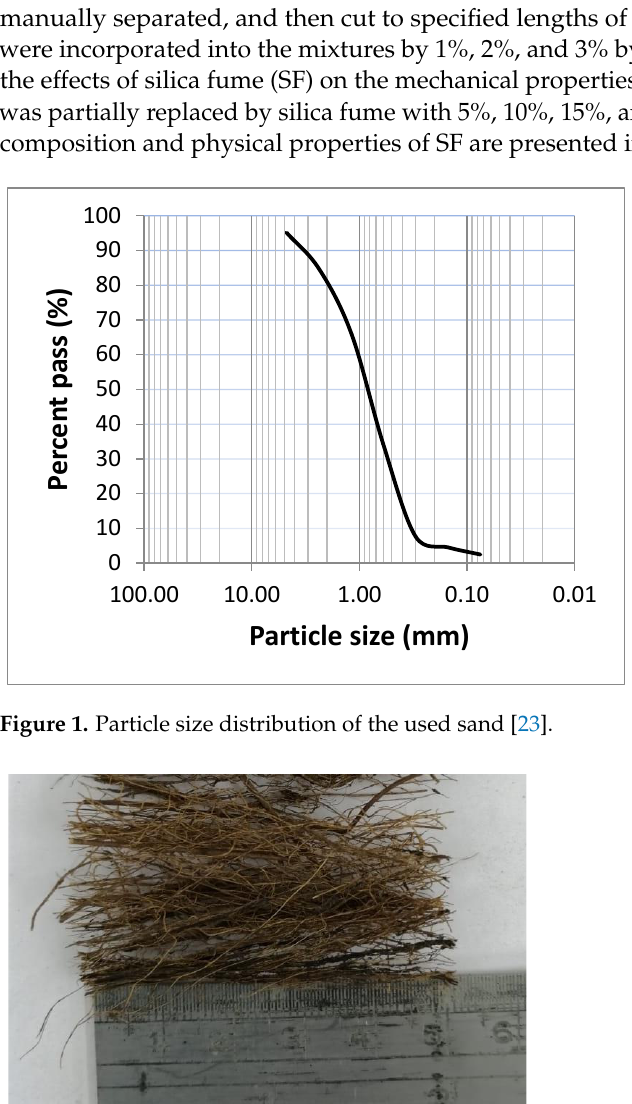
1:2 Figure 3 shows the flow chart of the mixing procedure. The sand, cement, and SDPMFs were put together into the mixer, and the mixer was operated for about one mi- nute to ensure the SDPMFs are equally distributed among the mixture. The mixing water was then gradually added, and the mixer was run for about 3 min. The mortar was then